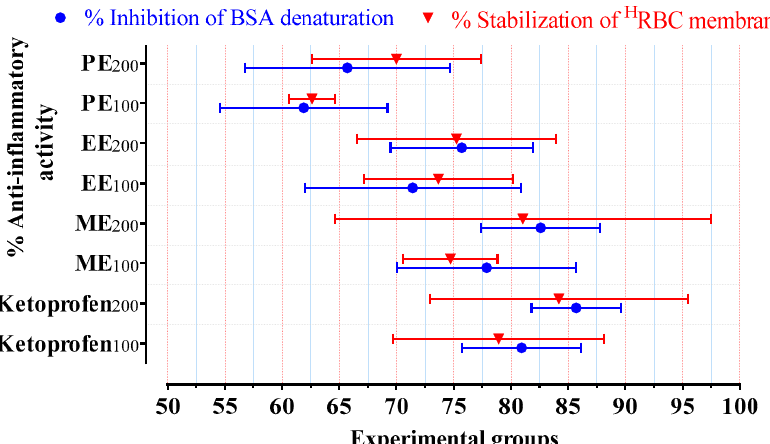
Figure 3. In vitro anti-inflammatory activity of ester prodrugs of ketoprofen assayed by BSA denaturation (blue) and human red blood cell haemolysis (red) techniques. Ketoprofen 100 and Ketoprofen 200 : Ketoprofen 100 mg/kg and 200 mg/kg respectively, ME 10 : Methyl 2-(3-benzoyl phenyl) propanoate (10 mg/kg), ME 50 : Methyl 2-(3-benzoyl phenyl) propanoate (50 mg/kg), ME 100 : Methyl 2-(3-benzoyl phenyl) propanoate (100 mg/kg), EE 10 : Ethyl 2-(3-benzoyl phenyl) propanoate (10 mg/kg), EE 50 : Ethyl 2-(3-benzoyl phenyl) propanoate Ethyl 2-(3-benzoyl phenyl) propanoate (50 mg/kg), EE 100 : Ethyl 2-(3-benzoyl phenyl) propanoate (100 mg/kg), PE 10 : Propyl 2-(3-benzoyl phenyl) propanoate (10 mg/kg), PE 50 : Propyl 2-(3-benzoyl phenyl) propanoate (50 mg/kg) and PE 100 : Propyl 2-(3-benzoyl phenyl) propanoate (100 mg/kg). Data was expressed as mean ± SEM, where n = 3.